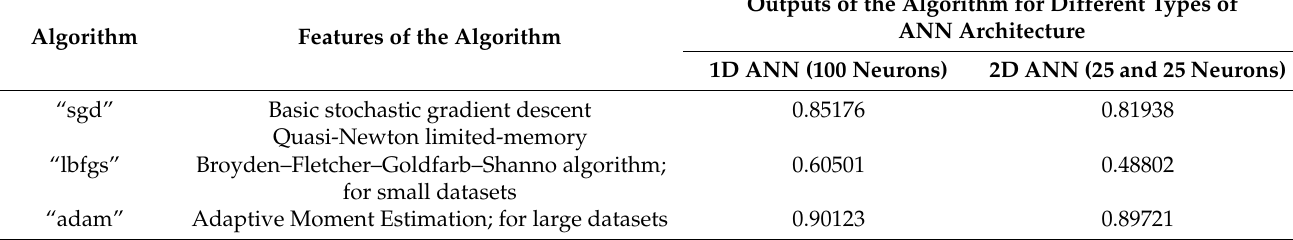
Table 5. Comparison of solvers’